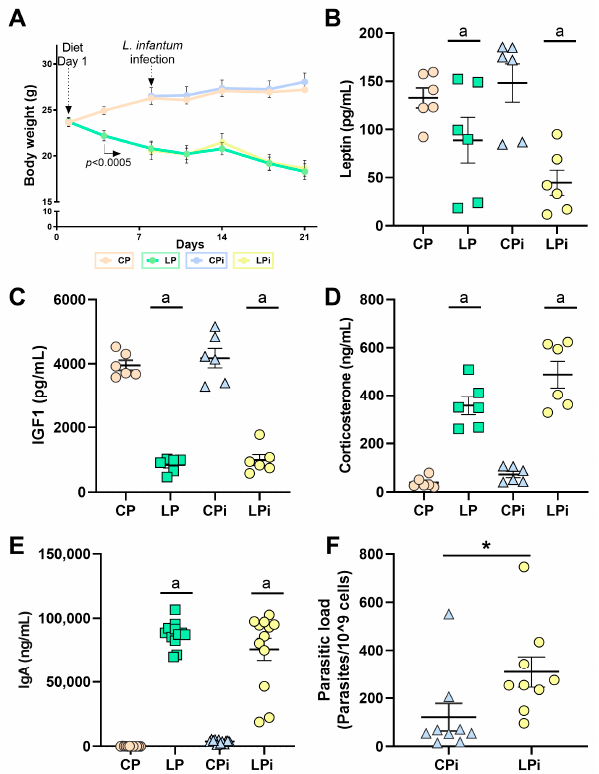
Figure 1. Bodyweight and hormonal levels in malnourished BALB/c mice infected with L. infantum . ( A ) Male BALB/c mice were fed a 14% ( n = 24, control protein (CP)) or 4% ( n = 24, low protein (LP)) protein diet for 21 days. On day 7 of the experimental period, half of the animals were infected with L. infantum and the other half received an injection of saline solution. Bodyweight was recorded every third day and expressed as average ± SEM; n = 12 mice in each group. Statistical differences before the day of infection were determined by Student’s t -test ( p < 0.0005). After infection, a two-way ANOVA with Tukey’s post-hoc test was used ( p < 0.0001). ( B ) Leptin, ( C ) total IGF-1 (Insulin-like growth factor 1), ( D ) corticosterone, and ( E ) immunoglobulin A (IgA) serum levels were analyzed in the experimental groups ( n = 6 per group). Leptin, IGF-1, and IgA were measured by commercial ELISA assays, whereas corticosterone was measured by radioimmunoassay. Statistical differences due to diet (a), infection (b), or (c) interaction between diet and infection were determined by two-way ANOVA ( p < 0.05). ( F ) Parasite load was determined by qPCR in the spleen and statistical differences were determined by Student’s t -test (* p < 0.05). CP: control protein, animals fed 14% protein diet; LP: low protein, animals fed 4% protein diet, CPi: animals fed 14% protein diet and infected; LPi: animals fed 4% protein diet and